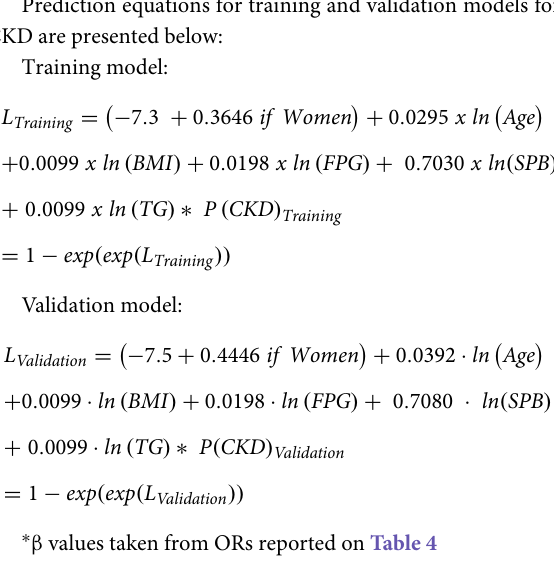
b Cardiovascular disease: Acute myocardial infarction, angina pectoris, stroke, heart failure,andotherheartdiseases.BMI,bodymassindex.